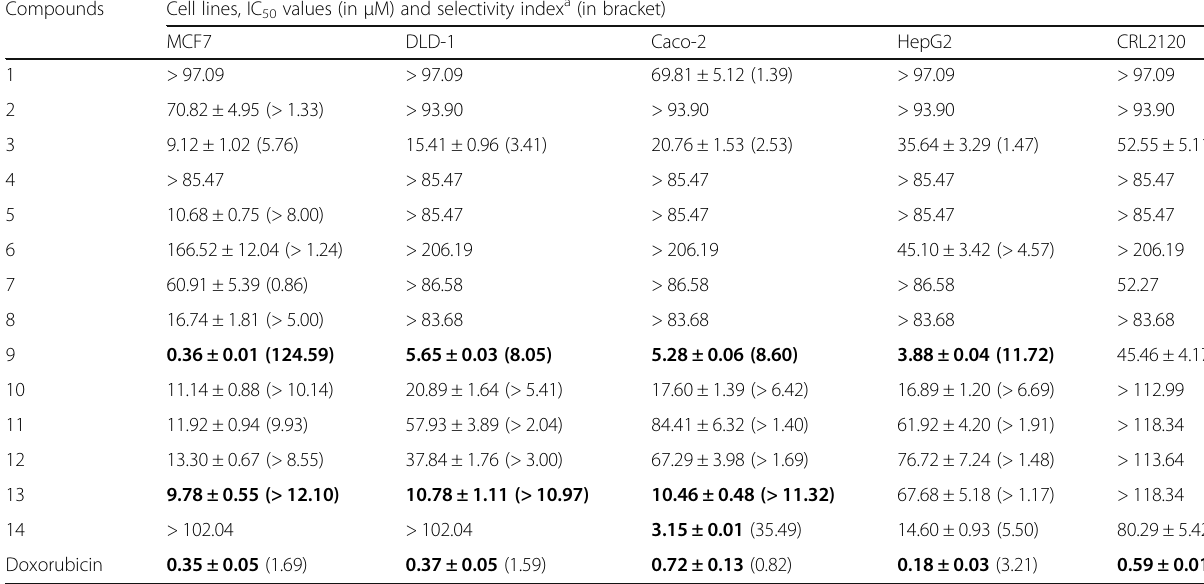
Table 1 Cytotoxicity of tested compounds and doxorubicin in carcinoma and normal cell lines using NR assay Compounds Cell lines, IC 50 values (in μ M) and selectivity index a (in bracket)